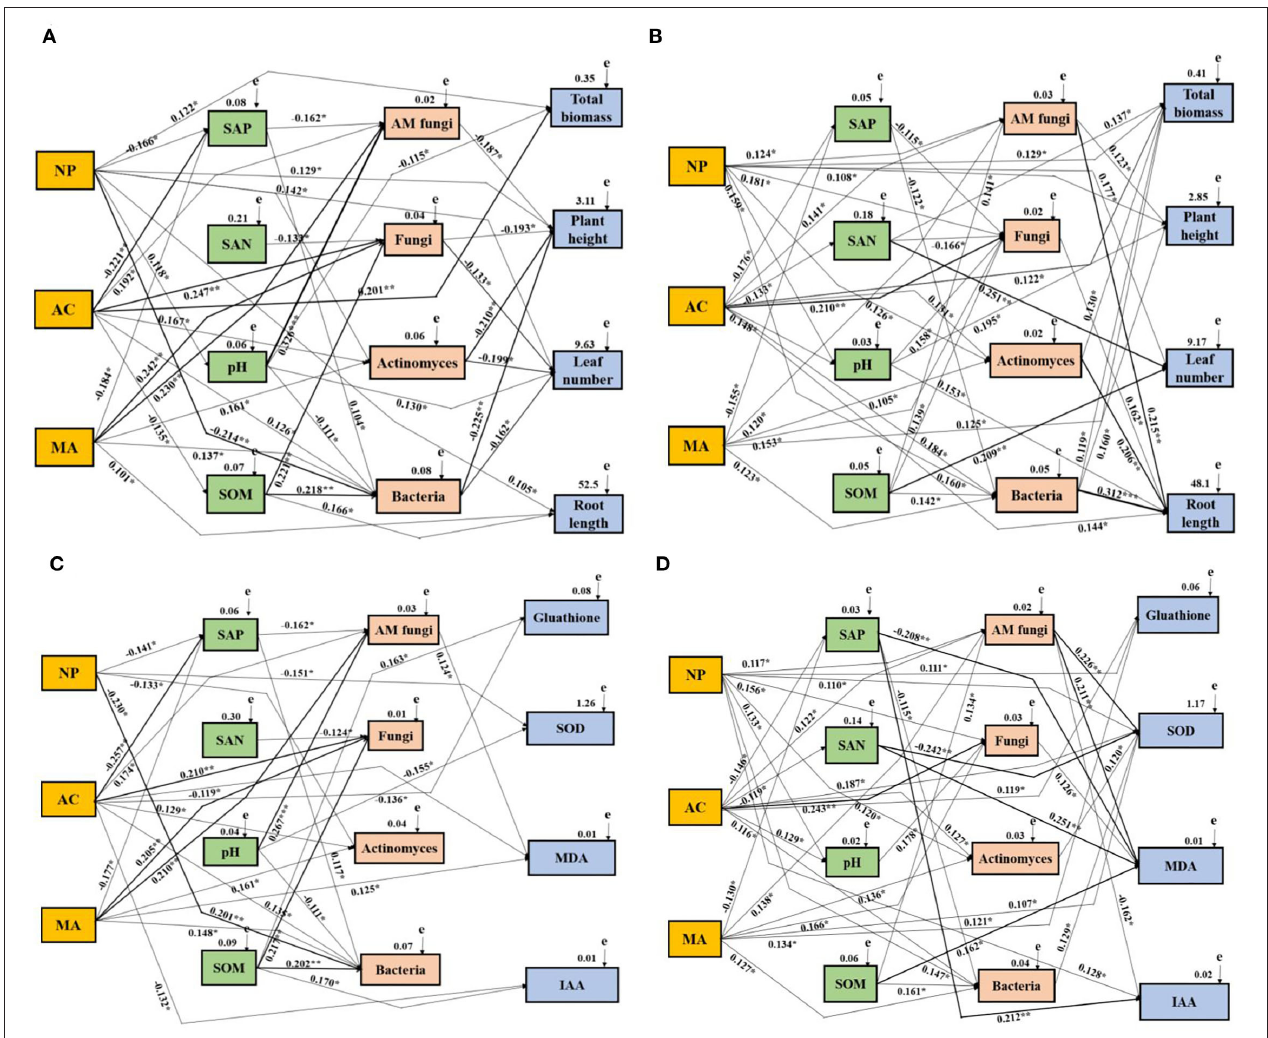
FIGURE 7 | Structural equation model showing the causal relationships among DSE species, soil parameters, soil microbes, and growth and physiological parameters. The final model fitted the data well:maximum likelihood. Growth parameters under WW condition: (A) X 2 = 62.166, df = 9, p = 0.008, RMSEA (root mean square error of approximation) = 0.256, GFI (goodness-of-fit index) = 0.588, AIC (Akaike information criteria) = 168.167; Growth parameters under DS condition: (B) X 2 = 67.557, df = 10, p = 0.006, RMSEA = 0.273, GFI = 0.569, AIC = 173.058; Physiological parameters under WW condition: (C) X 2 = 48.158, df = 6, p = 0.018, RMSEA = 0.225, GFI = 0.779, AIC = 152.037; Physiological parameters under DS condition: (D) X 2 = 55.666, df = 7, p = 0.011, RMSEA = 0.241, GFI = 0.633, AIC = 162.025. The solid and dashed lines indicate whether the path of action between different factors is significant or not, respectively. The width of the solid line indicates the strength of the effect between the different factors, and the numbers near the arrows indicate the normalized path coefficients (* p < 0.05, ** p < 0.01, and *** p < 0.001). NP, Neocamarosporium phragmitis ; AC, Alternaria chlamydospore ; MA, Microascus alveolaris ; SAP, soil available P; SAN, soil available N; SOM, soil organic